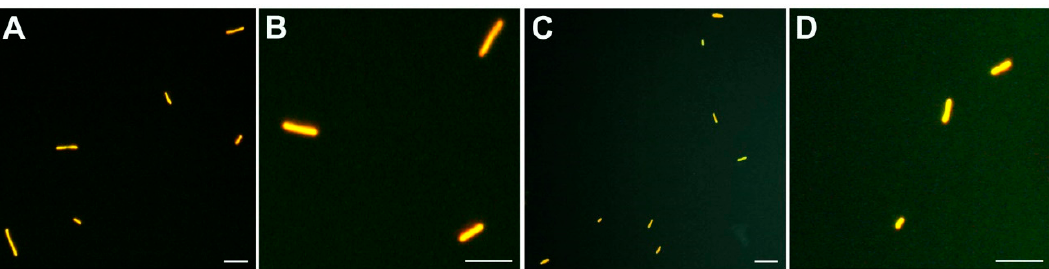
Figure 5. Viability of Ralstonia solanacearum strain IVIA-1602.1 populations at 40 days post-inoculation in the environmental water microcosms. ( A , B ) starved cells at 24 °C, and ( C , D ) starved and cold-induced VBNC cells at 4 °C. Viability was similar between starved ( A , B ) and VBNC ( C , D ) R. solanacearum cells, although in ( C , D ) cells were no culturable on solid media. For VBNC cells, this time was considered time zero of VBNC induction of the R. solanacearum populations in the resuscitation assays. Viability was measured by the DVC method and subsequent staining with acridine orange [41,42], and estimated in 10 6 VBNC cells/mL. Scale bars: 5 µm.